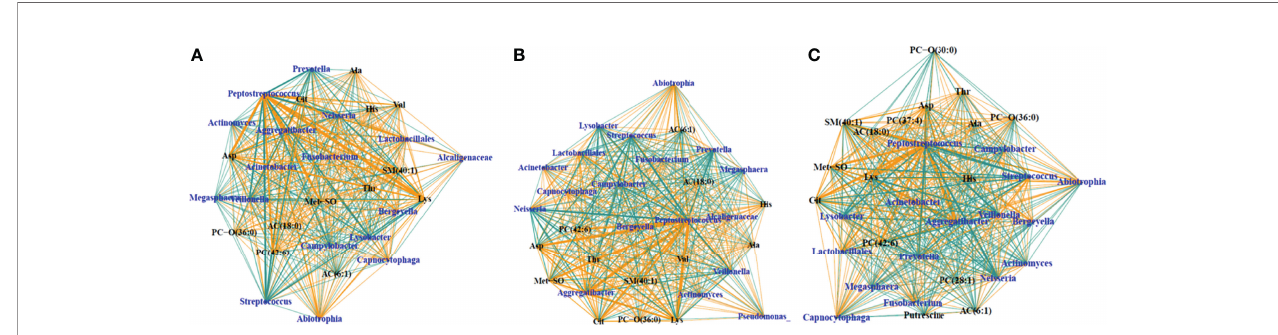
FIGURE 5 | Trimmed module subnetworks identifying microbiome metabolome correlations with no phenotypic outcome (A) , WBC phenotype (B) and percent neutrophil outcome (C) . Yellow edges indicate positive correlations and turquoise edges indicate negative correlations. Wider network edges indicate stronger correlations. Blue nodes are taxa identi fi ed in 16S and black nodes